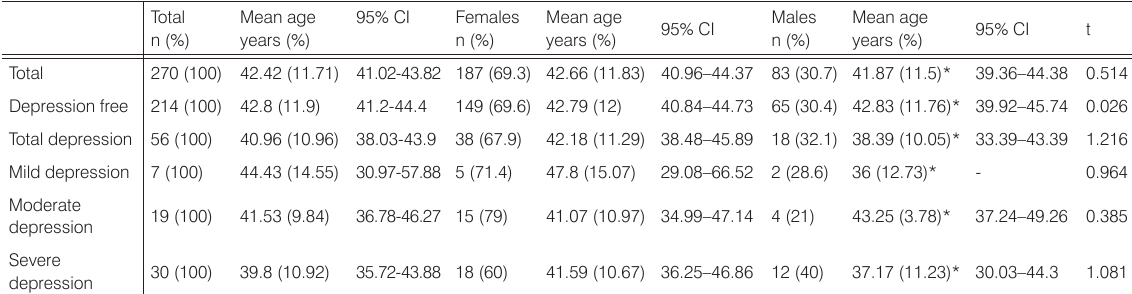
Table 1. Mean age characteristics of material considering prevalence of